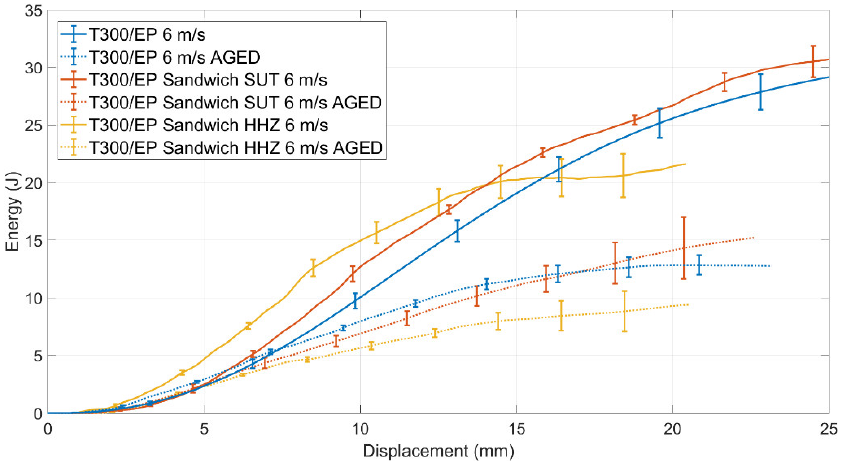
Figure 3. Energy-displacement mean curves for untreated and aged specimens of T300/EP composite.